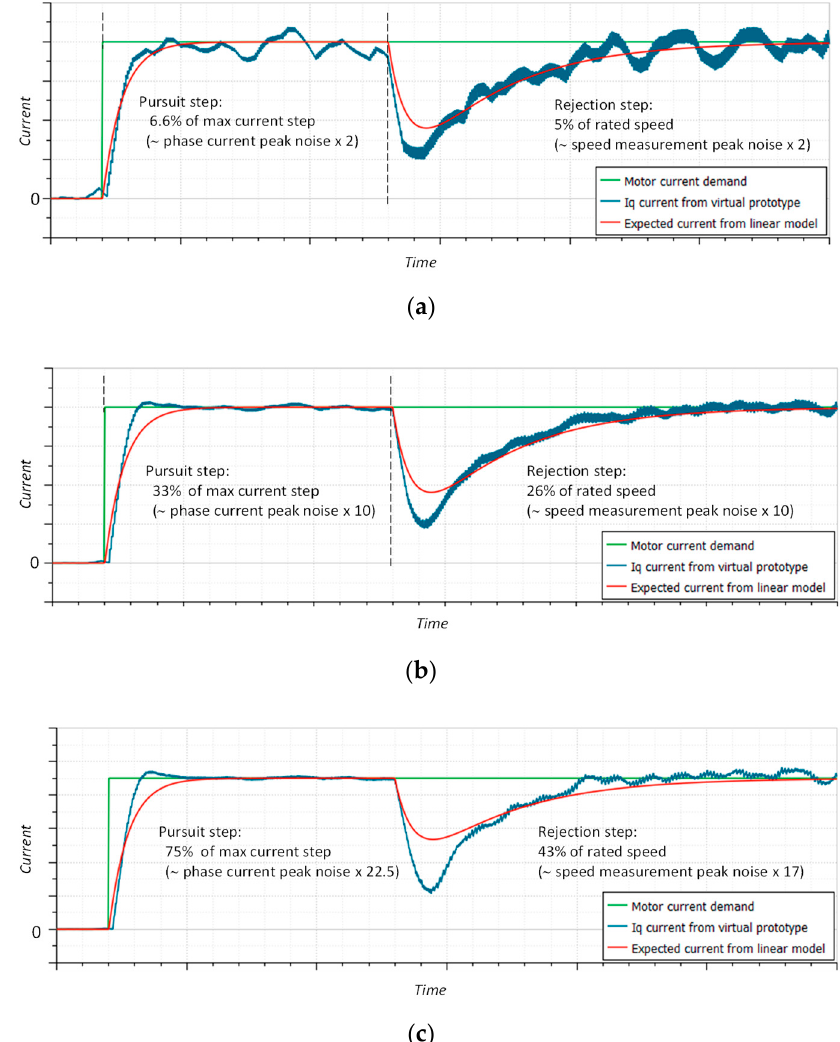
Figure 8. Time response of the current loop for step excitations: ( a ) small-magnitude excitations, noise effects magnified; ( b ) medium-magnitude excitations, operation close to linear; and ( c ) large- magnitude excitations, close to internal